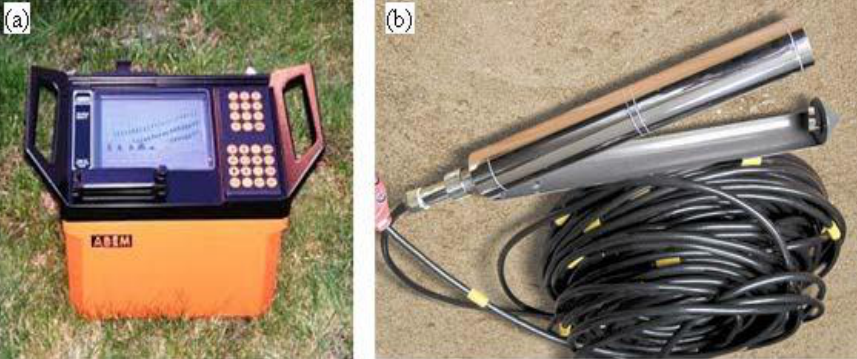
Figure 8. Seismograph and down-hole detector; ( a ) ABEM Terraloc MK8 seismograph, ( b ) downhole Figure8. Seismographanddown-holedetector;( a )ABEMTerralocMK8seismograph,( b detector.